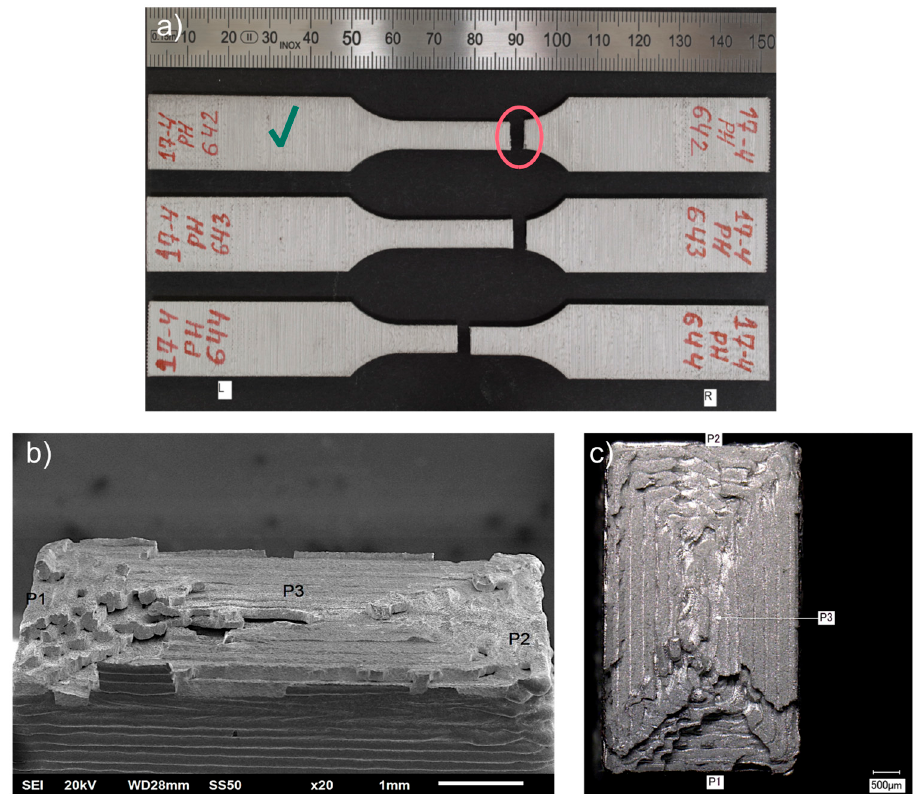
Figure 12. Fatigue fractures of Markforged 17-4 PH samples: presented as: ( a ) fractured specimens during the fatigue test; ( b ) fracture surface (SEM image), left side, specimen 642, at 4770 cycles; ( c ) top view of fracture surface (SEM image), left side, specimen 642, at 4770 cycles. The samples have been numbered, which are visible in the figure. The letters L and R stand for the left-hand and right-hand sides of the sample in the figure. A green check mark means the specimen whose fracture faces were shown.